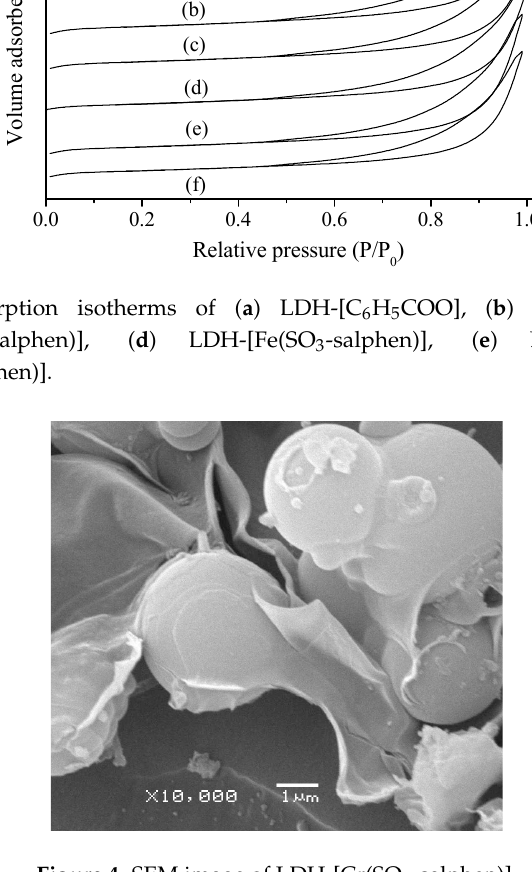
Figure 4. SEM image of LDH ‐ [Cr(SO 3 ‐ salphen)].